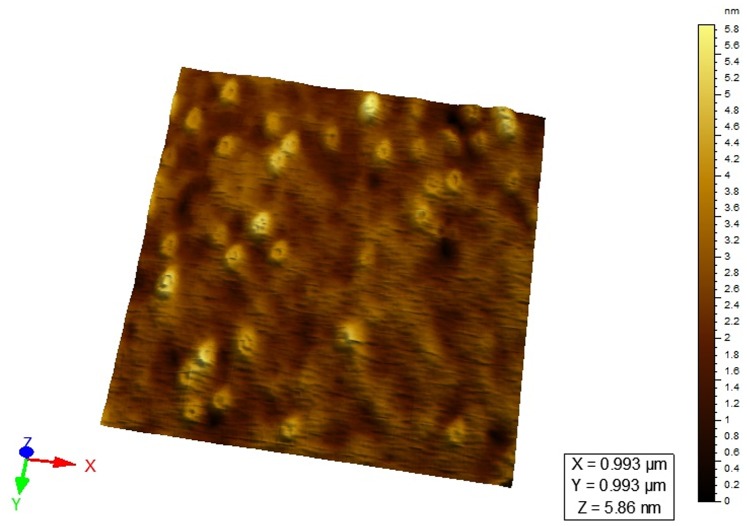
AFM study of AGnps after 192 hours of AG release.
AFM studies were carried out separately on particles sampled after 192 hours of dissolution. AGnps sampled after 600 hours of release showed a distinct itching on polymeric nanoparticle surface. This fact clearly indicated that, in later part of dissolution study, nanoparticle surface erosion associated with in vitro drug release took place.